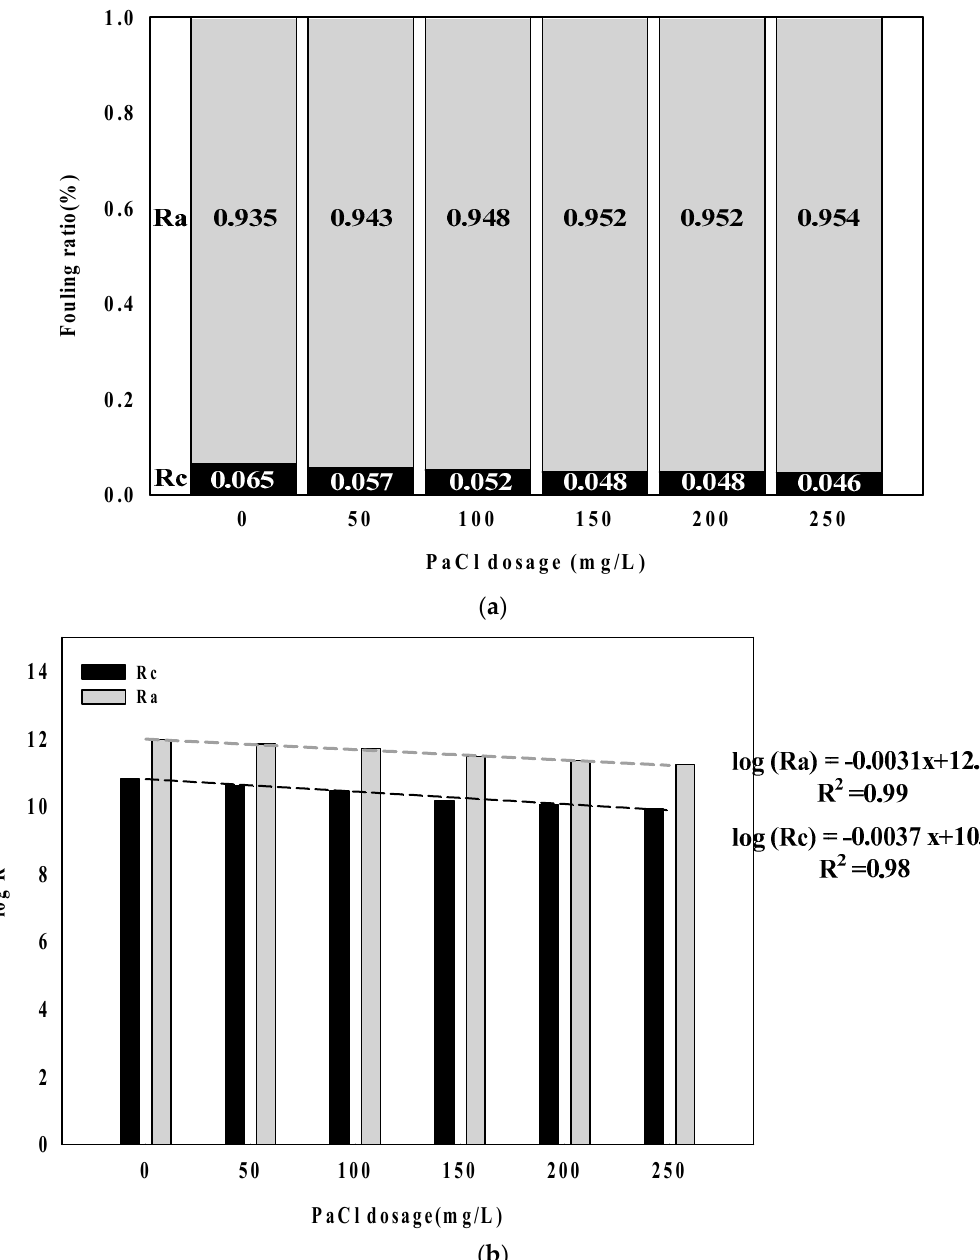
Figure 3. Analysis results of fouling characteristics with coagulant dosage. ( a ) Fouling ratio; and ( b ) log (R a & R c ).